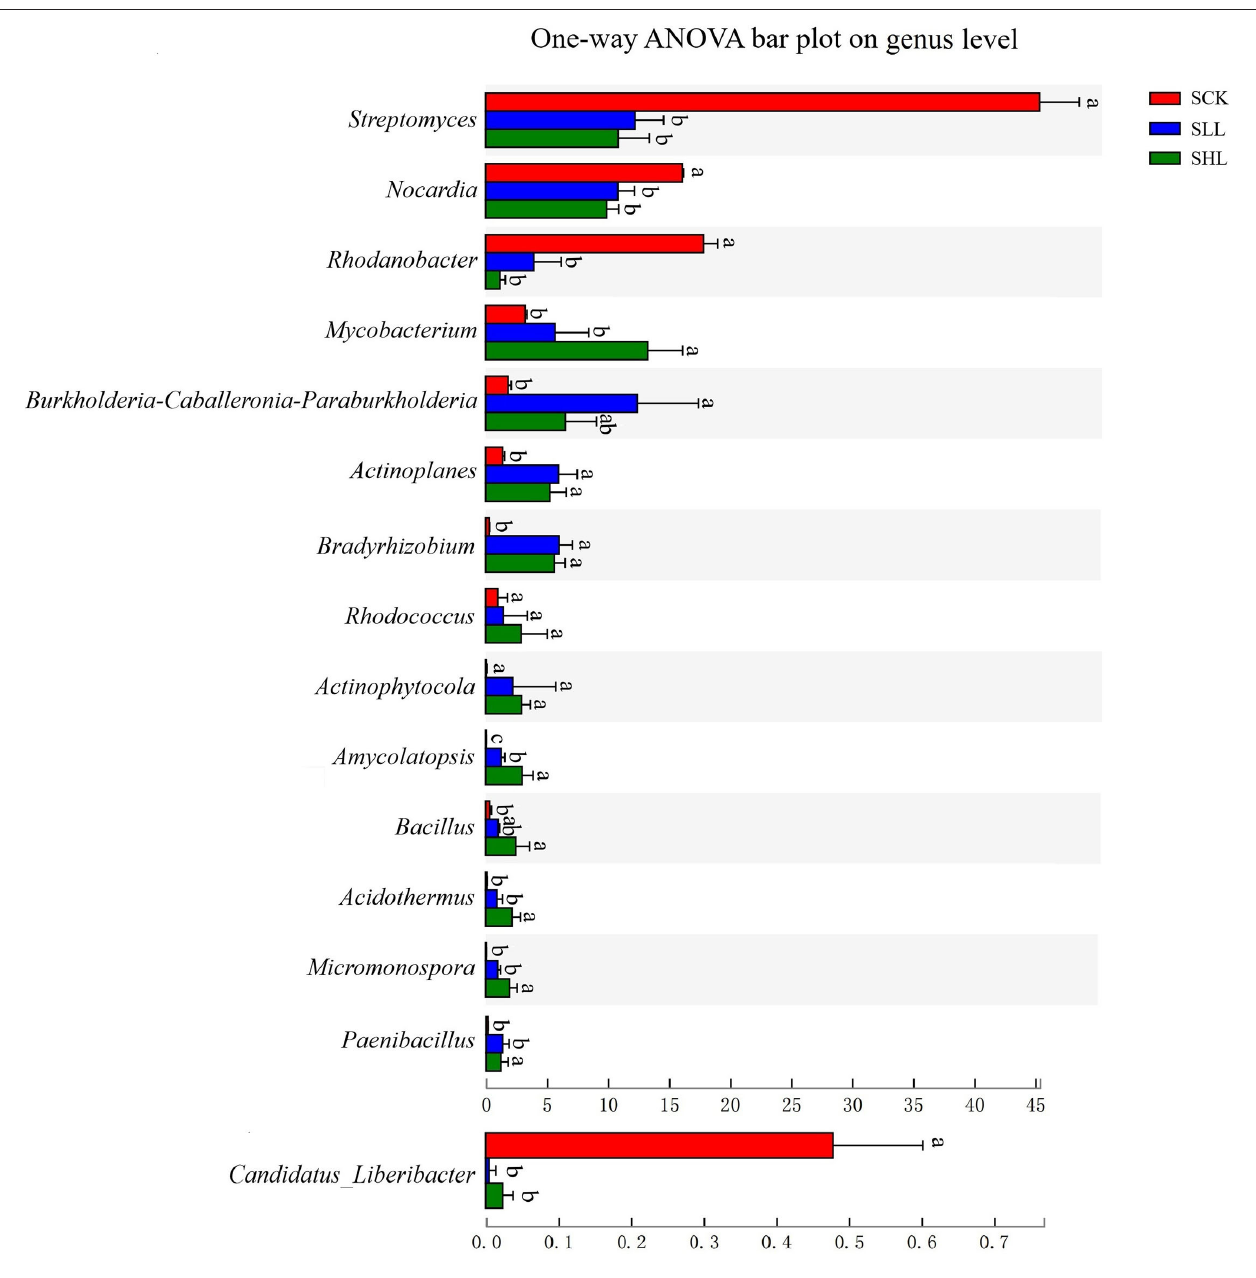
FIGURE 3 | Relative abundances of bacterial taxa at the genus level showed significant differences among HLB-infected root samples from SCK, SLL, and SHL soils. SCK, soil without lime treatment; SLL, soil treated with low-level lime; SHL, treated with high-level lime. Differences were considered significant at p < 0.05 by the Kruskal Wallis H test and respective significant differences were marked using different letters among indicated